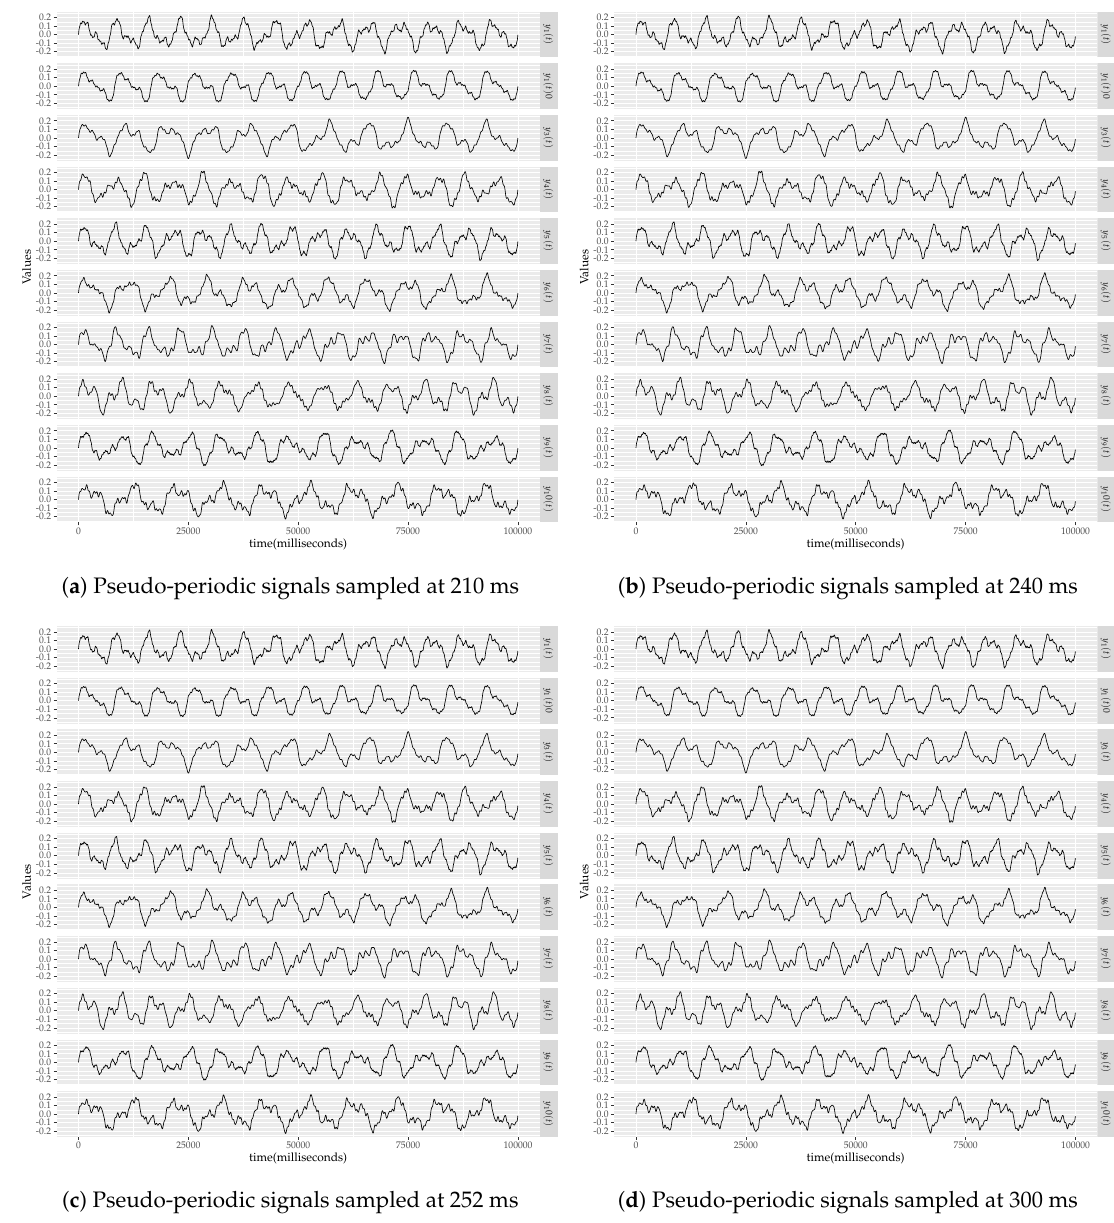
Figure 2. Pseudo-periodic signals sampled at ( a ) 210, ( b ) 240, ( c ) 252, ( d ) 300